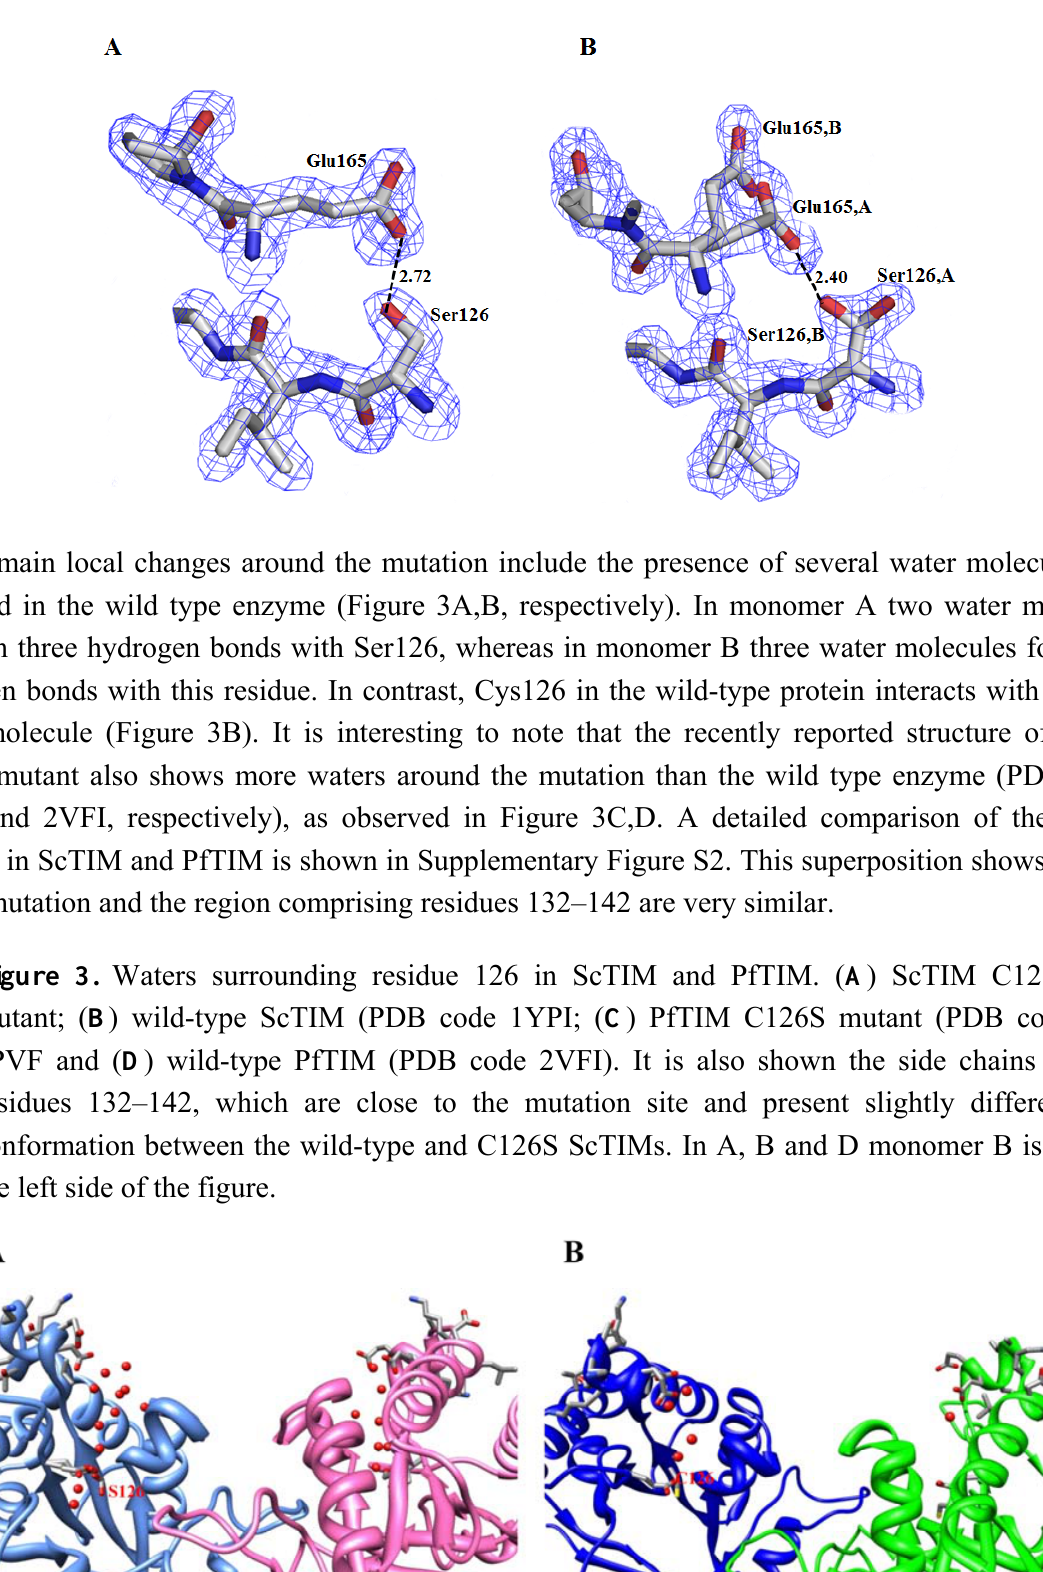
Figure 2. 2Fo-Fc electron density map contoured at 1.0 σ showing the mutation (Ser126) and the new hydrogen bond established with Glu165. ( A ) Monomer A (ligand-bound); ( B ) Monomer B (ligand-free). In the latter, both Ser126 and Glu165 present a double conformation.